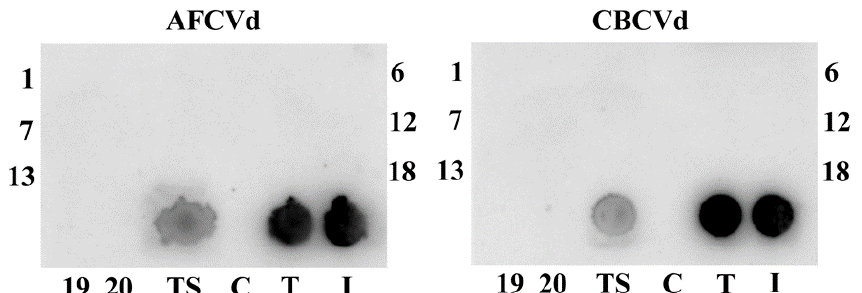
Figure 3. An example of dot-blot analysis of N. benthamiana offspring from AFCVd- or CBCVd-infected and transformed plants with infectious viroid cDNAs. Crude extracts from tissues of seedlings or upper leaves of flowering plants used as pollen sources were performed. Extract (25 μL ) was dotted to nylon membrane and analyzed by hybridization to α 32 P-labelled cDNA of either AFCVd or CBCVd probes. 1–20, extracts from individual three weeks old seedlings from seeds collected from N. benthamiana plants infected after A. tumefaciens infiltration (I). TS, mixed extracts from one-week-old seedlings from seeds collected from viroid cDNA-transformed N. benthamiana (T). Healthy control (C).